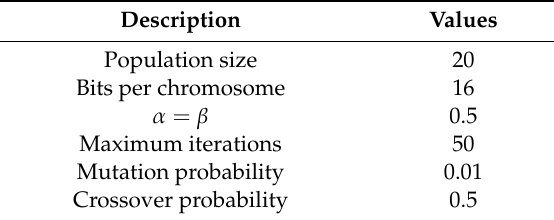
Table 4. GA parameters.